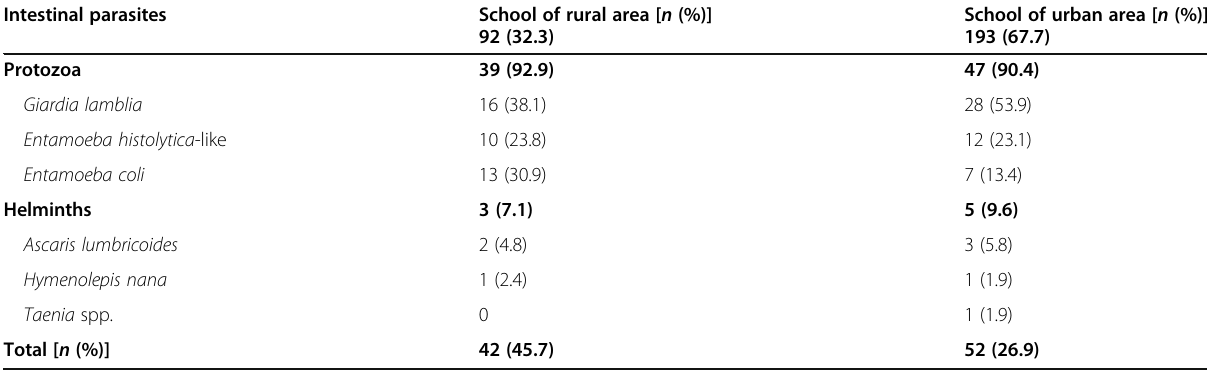
Table 2 School-wise distribution of intestinal parasitic infections Intestinal